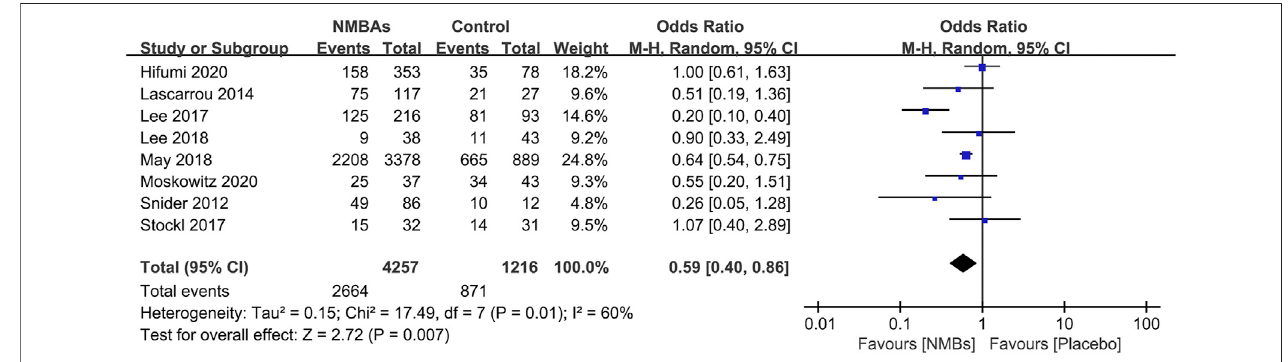
FIGURE 1 | The selection process for studies included in the